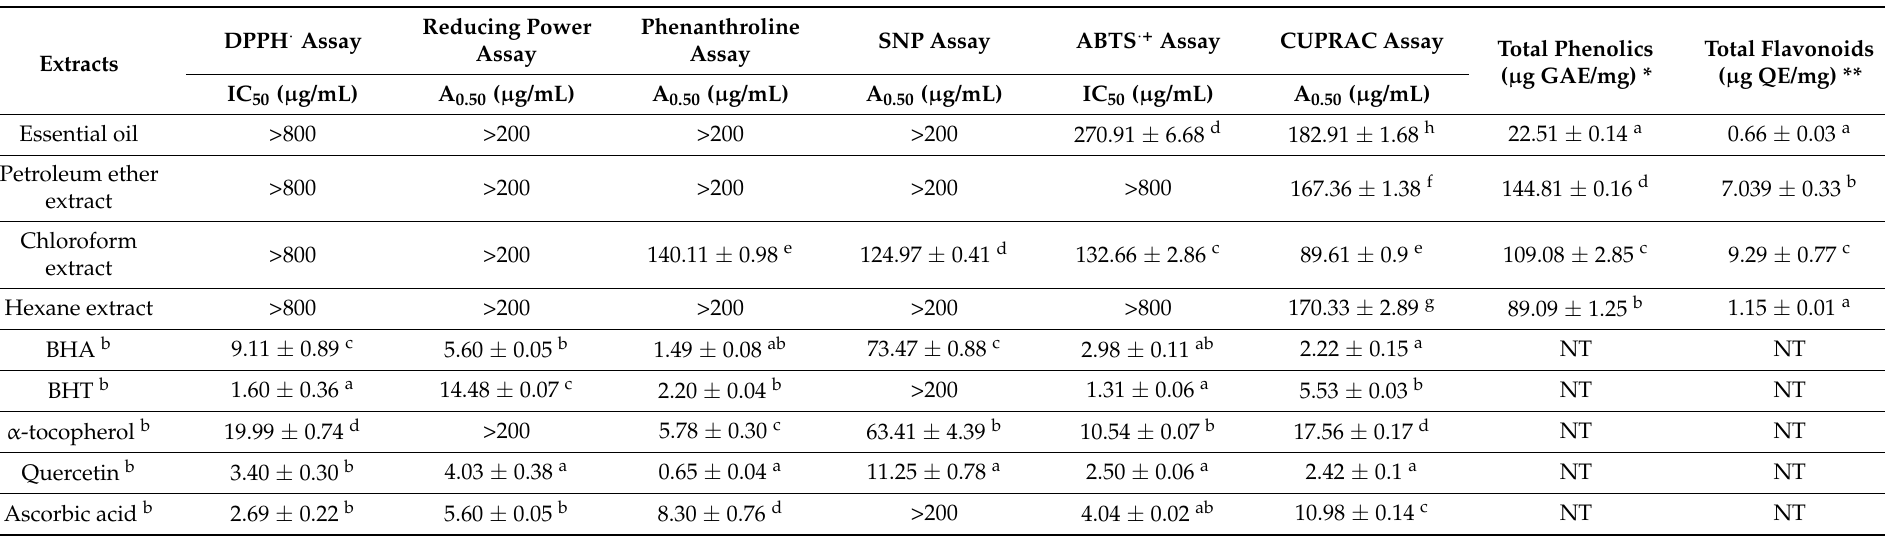
Table 1. Antioxidant activity with phenolic and flavonoid content of nonpolar extracts and essential oil of Mentha piperita by DPPH • , ABTS • + , CUPRAC, reducing power, phenanthroline, and silver nanoparticle (SNP)